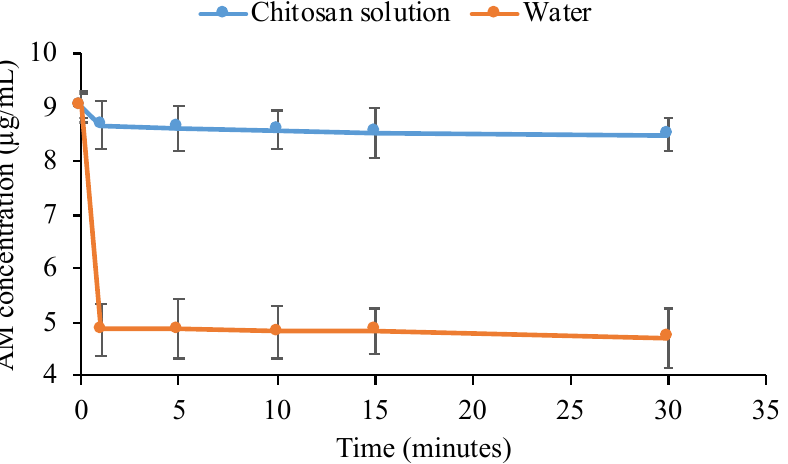
Figure 6. The concentration of AM in the water and WSC solutions for 30 min ( n = 3, mean ± standard deviation).